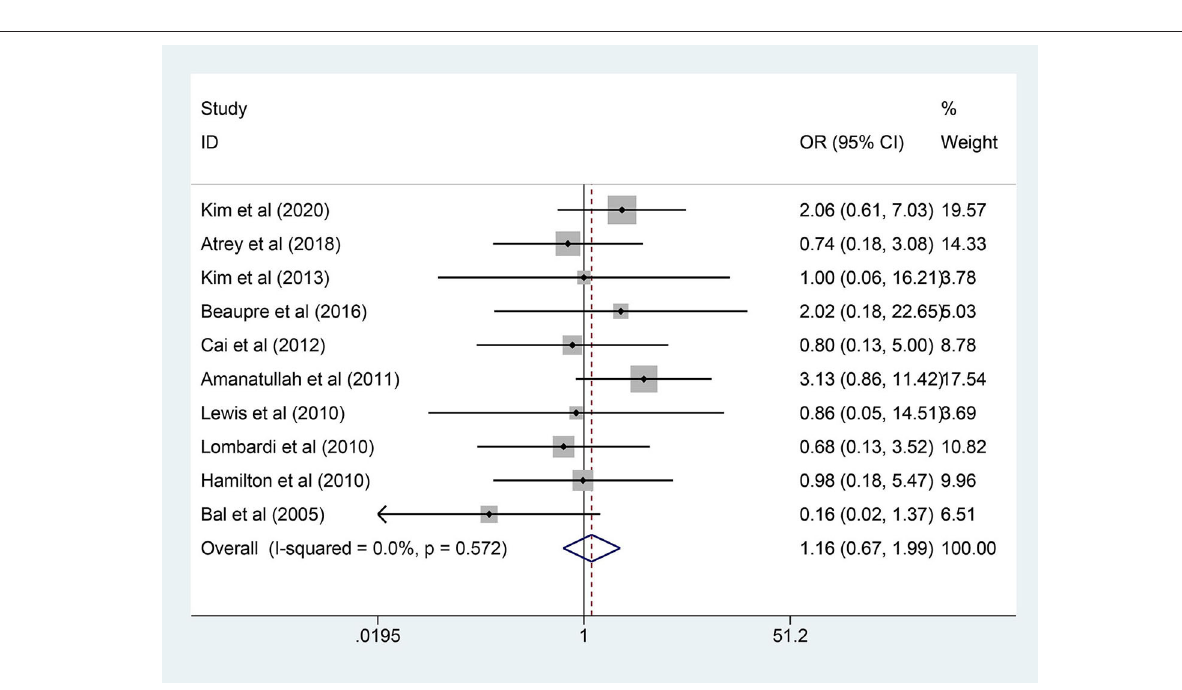
FIGURE 4 | Forest plot diagram of the overall revision rate of the replaced hip with COC and COP bearing